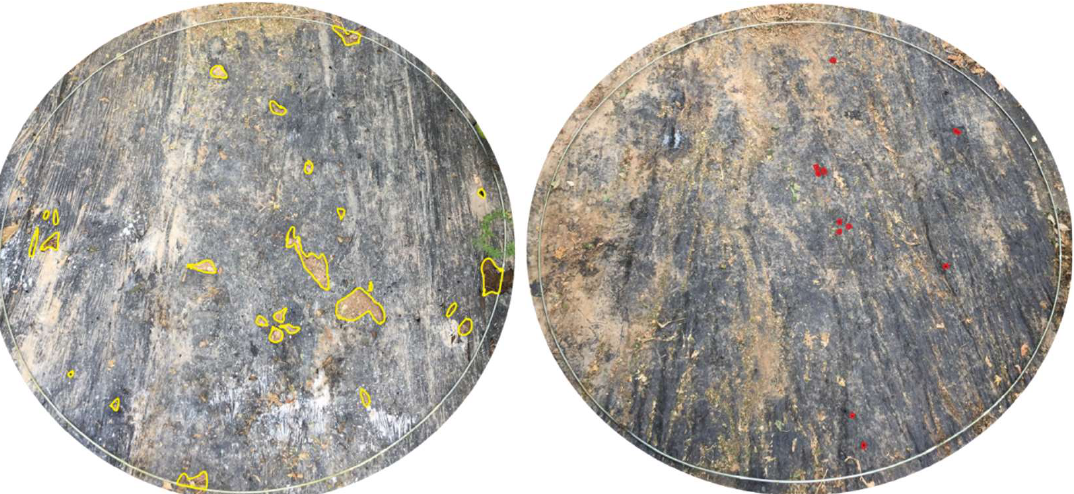
Figure 8. Visual deterioration of biodegradable biopolymer (( left ); deteriorated area in yellow color) and polyethylene (( right ); deteriorated area in red color) plastic mulches at the end of the crop season in Year 2 (195 days after planting). Surfaces occupied by the ring (1 m 2 ) were processed with software to obtain the deteriorated area ( perforations and/or breaks).